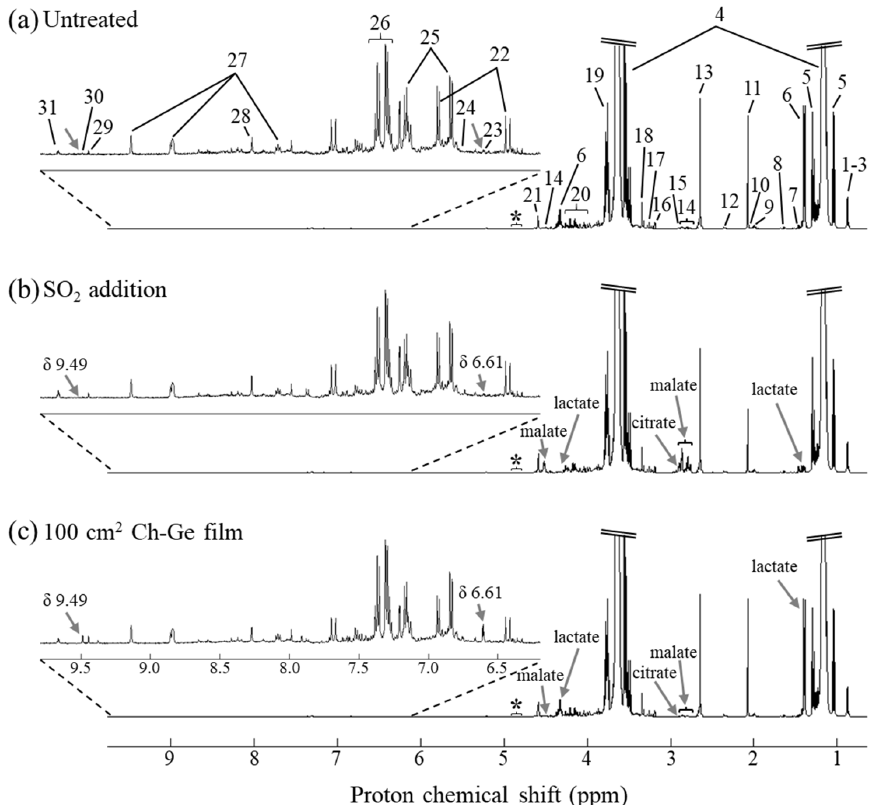
Figure 2. The 500 MHz 1 H NMR average spectra of white wines varying in treatment strategy, as follows: ( a ) untreated, ( b ) treated with 40 mg/L of SO 2 and ( c ) treated with 100 cm 2 Ch-Ge films, with inset shown for the expanded aromatic region (6–10 ppm). Peak assignments: 1–3, higher alcohols (1: isobutanol; 2: 1-propanol; 3: isopentanol); 4, ethanol; 5, ethanol satellites; 6, lactate; 7, unassigned resonance at δ 1.46, doublet; 8, alanine; 9, proline; 10, ethyl acetate; 11, acetate; 12, pyruvate; 13, succinate; 14, malate; 15, citrate; 16, choline; 17, myo-inositol; 18, methanol; 19, glycerol; 20, sugar resonances (including glucose and fructose); 21, tartarate; 22, ferulate; 23, unassigned resonance at δ 6.61, doublet; 24, fumarate; 25, tyrosol; 26, phenylethanol; 27, trigonelline; 28, formate; 29, 5-hydroxymethyl furfural (5-HMF); 30, unassigned resonance at δ 9.49, singlet; 31, acetaldehyde. Visually identified spectral variations between the different treatment samples are highlighted by arrows and full metabolite names in ( b ) and ( c ) spectra: lactate (1.46 ppm and 4.32 ppm), malate (2.80 ppm and 4.50 ppm), citrate (2.93 ppm), unassigned at δ 6.61, doublet, and unassigned at δ 9.49, singlet. * Water suppression region.